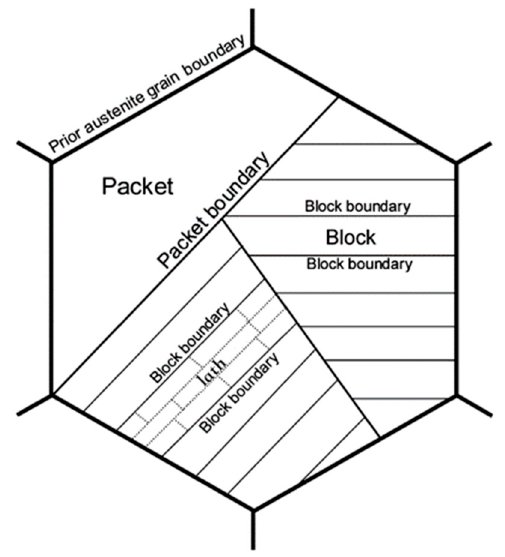
Figure 1. Schematic representation of microstructural hierarchy of lath bainite/martensite based on the available knowledge in literature [6].